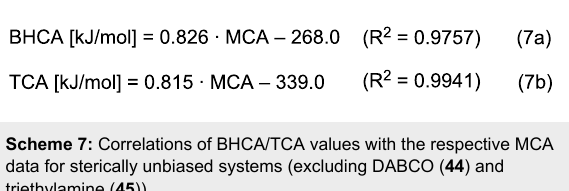
From Figure 9 it can be seen that most Lewis bases respond to the change from methyl cation (MCA) to benzhydryl cation (BHCA) and trityl cation (TCA) affinities in the same way, that is, with a large reduction of cation affinity. This is also reflected in the correlations of BHCA/TCA values with the respective MCA data for sterically unbiased systems (excluding DABCO ( 44 ) and triethylamine ( 45 )), which can quantitatively be expressed by equations 7a and 7b given in Scheme 7.